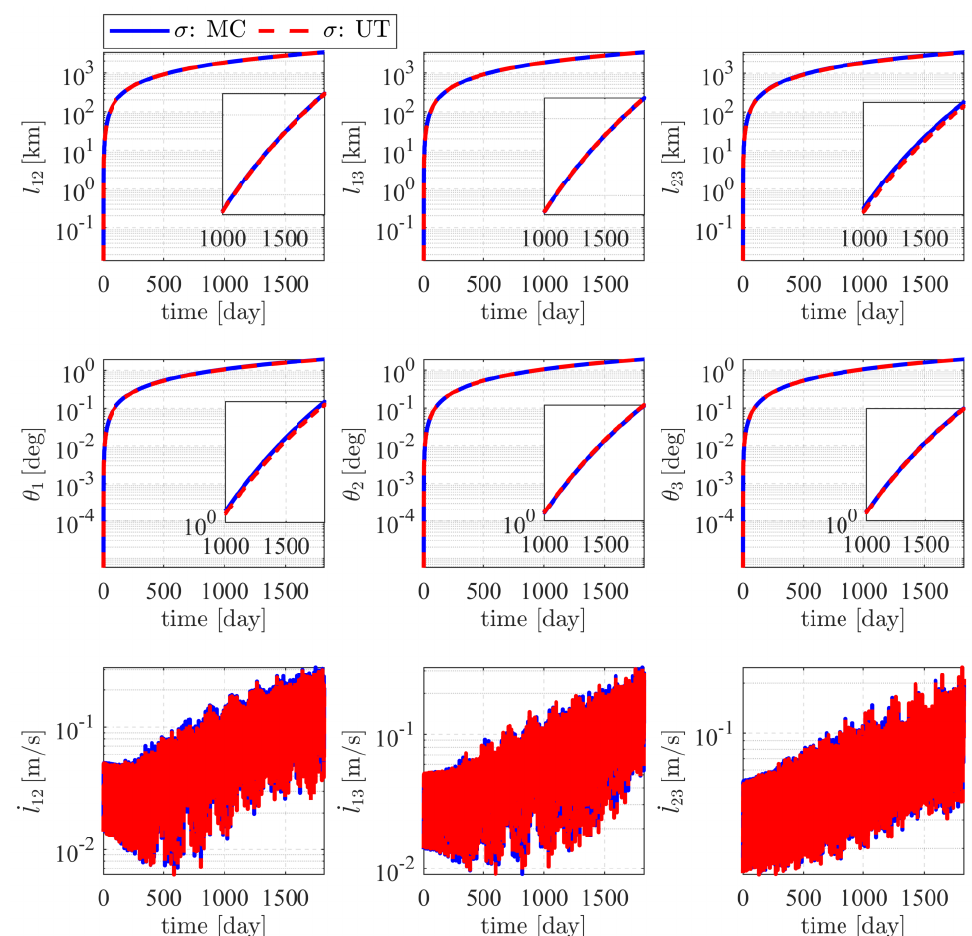
Figure 6. Comparison diagram of the UT ( κ = 9) and the Monte Carlo simulation. The blue lines and the red dashed lines respectively represent the results of the MC simulation and UT